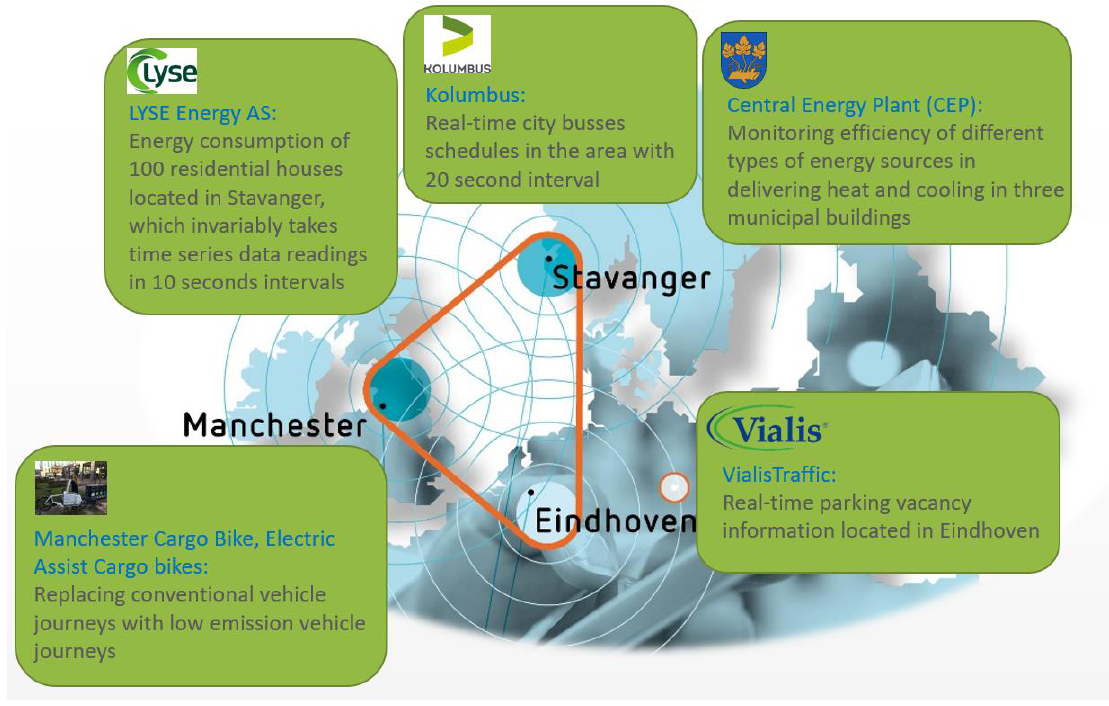
Figure 6. Sources of urban data.